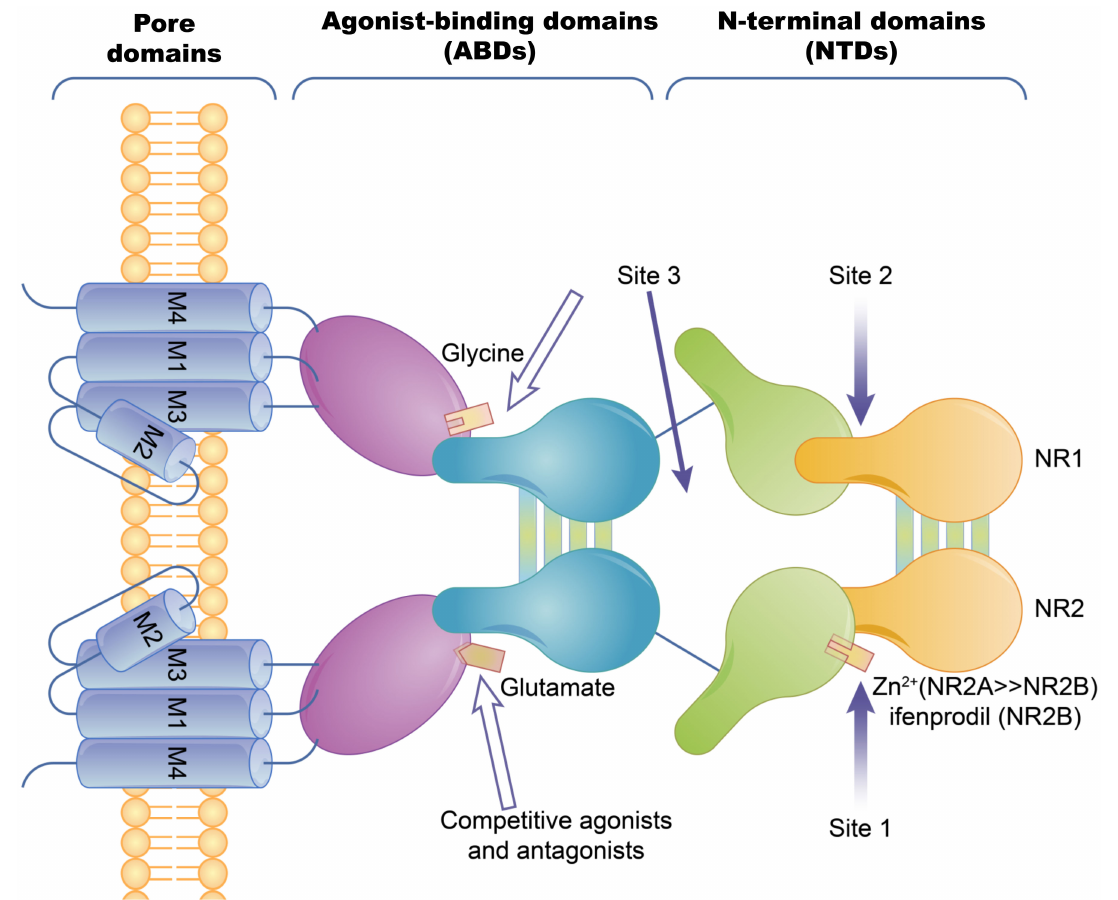
Figure 2. The basic structure of the NMDA ion-channel receptor. The NMDA receptor is composed of two NR1 subunits and two NR2 subunits in a dimer combination. Only one of the NR1/NR2 heterodimers is shown. The extracellular region of each subunit has two projections, the N-terminal and the agonist binding region, where the polymerization of subunits occurs at both the agonist binding region and the N-terminus. Agonist binding sites with glutamic acid are present in the NR2 subunit and glycine or serine binding sites are present in the NR1 subunit. Hollow arrows indicate the binding sites of competitive agonists or antagonists, and solid arrows indicate the regulatory sites for allosteric conditioning (e.g., zinc